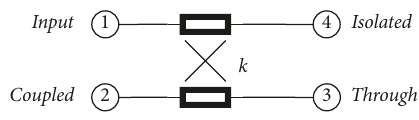
Figure 1: Schematic of transdirectional coupler.